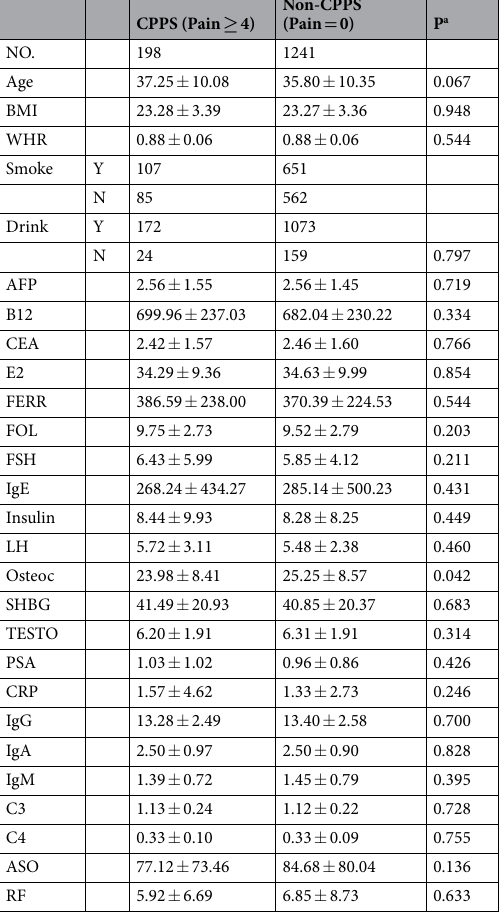
Table 1. The baseline characteristics of participants in our analysis. * The CP/CPPS was defined with pain evaluated by National Institutes of Health Chronic Prostatitis Symptom Index (NIH-CPSI). * CPPS: pain ≥ 4; Non-CPPS: pain = 0. * a the p values were calculated with Student’s t test, Mann—Whitney U test, and the Χ 2 test. * BMI = Body Mass Index; WHR = Waist Hip Rate; C3 = Complement 3; AFP = Alpha-fetoprotein; B12 = Vitamin B12; CEA = Carcino Embryonie Antigen; E2 = Estradiol; FERR = Ferritin; FOL = Folic acid; FSH = Follicle-Stimulating Hormone; IgE = Immunoglobulin E; LH = Luteinizing Hormone; Osteoc = Osteocalcin; SHBG = Sex Hormone Binding Globulin; TESTO = Testosterone; PSA = Prostate Specific Antigen; CRP = C reactive protein; ASO = Aso antistrptolysin o; RF = Rheumatoid